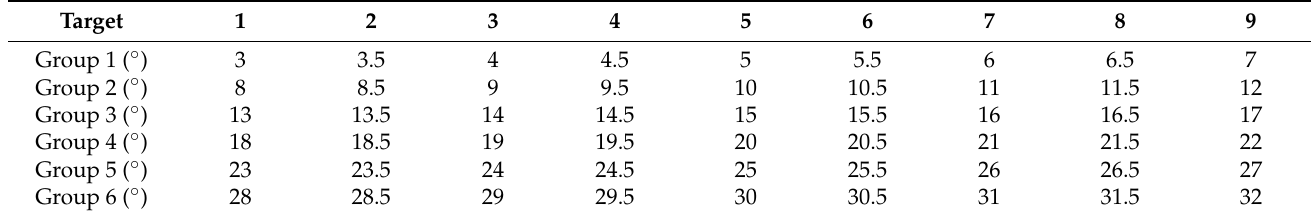
Table 2. Phase estimation errors of verification experiment.